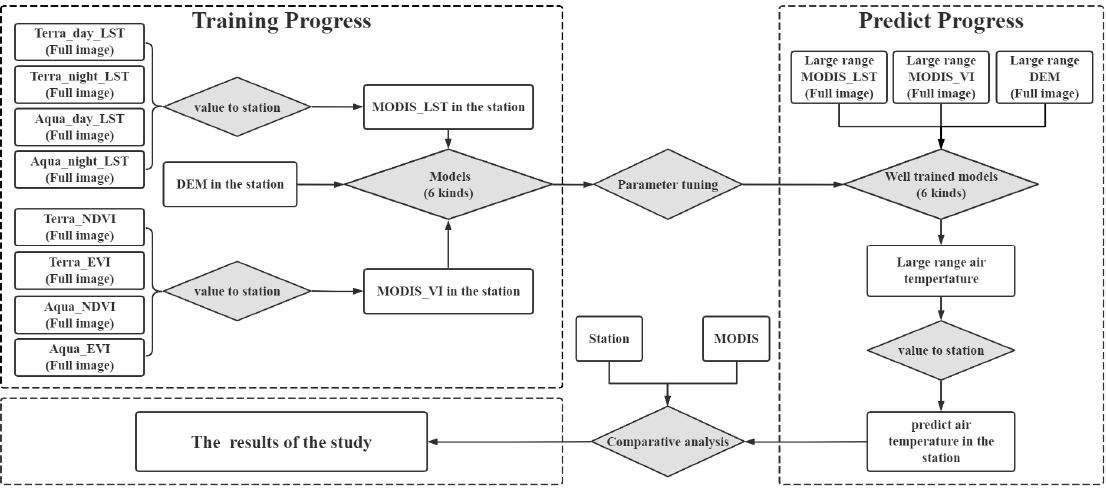
Figure 6. The methodological framework and flowchart for evaluation and comparison of selected models.